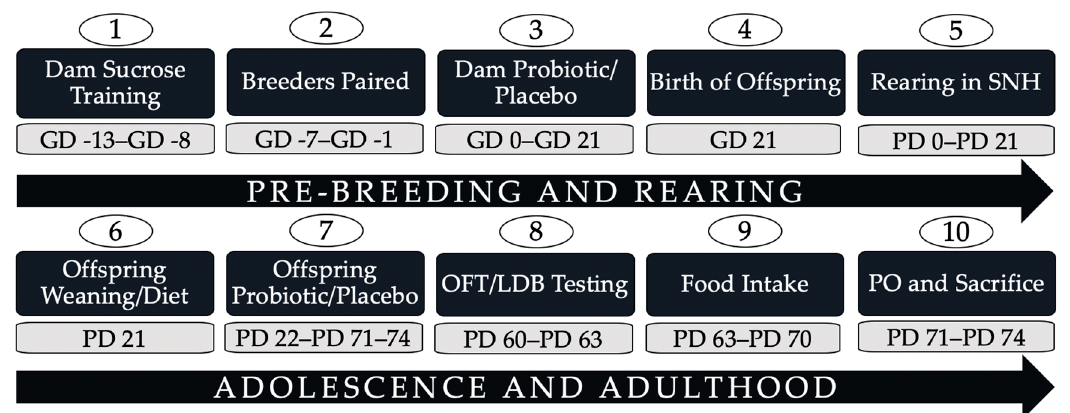
Figure 1. Experimental timeline (numbered in chronological order from 1 to10) from arrival of breeder rats until offspring sacrifices with gestational day (GD) 0 serving as the reference point for the timeline. PD: postnatal day (0 to 74); GD: gestational day ( − 13 to 21); SNH: semi-naturalistic housing; OFT: open field test; LDB: light–dark box; PO: predator odour.